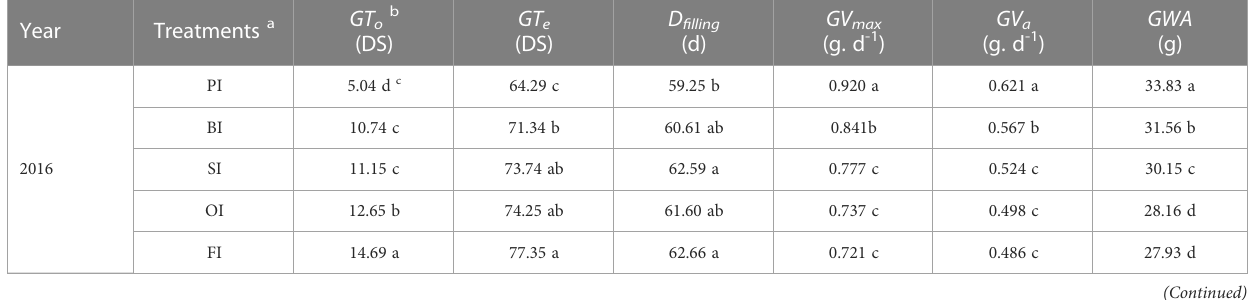
TABLE 5 Grain fi lling traits with the different drip irrigation treatments.